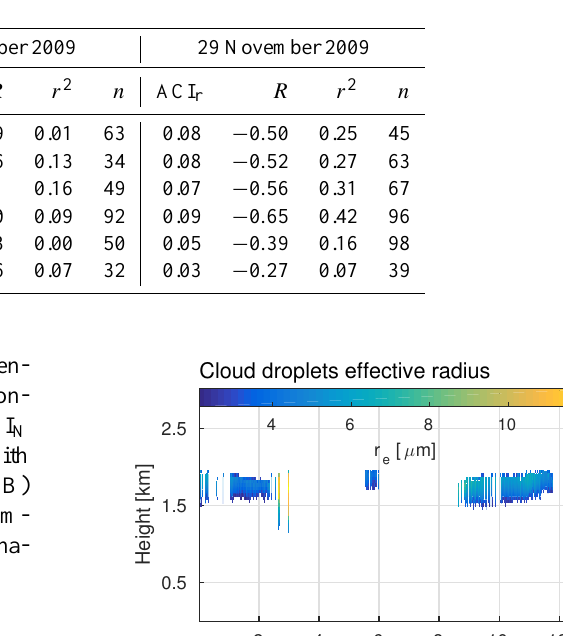
Table 2. ACI r (Eq. 5) and the statistical parameters calculated between ln (r e ) and ln ( ATB ) , namely Pearson product-moment correlation coefficient, R , and the coefficient of determination, r 2 , and the number of observations within the LWP bins, n , for two case studies from Graciosa Island, the Azores (3 and 29 November 2009).